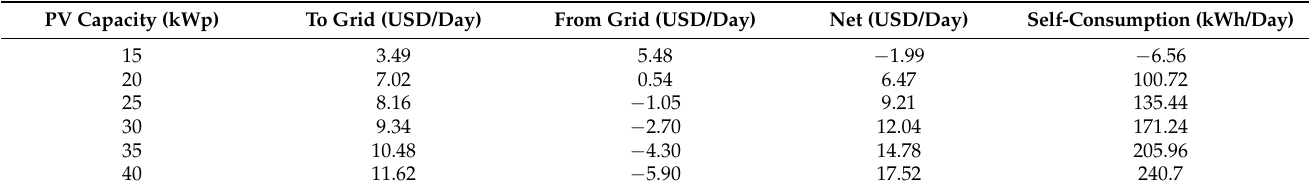
Table 8. Daily energy cost and self-consumption for different PV capacities (HKT = 5 kW).